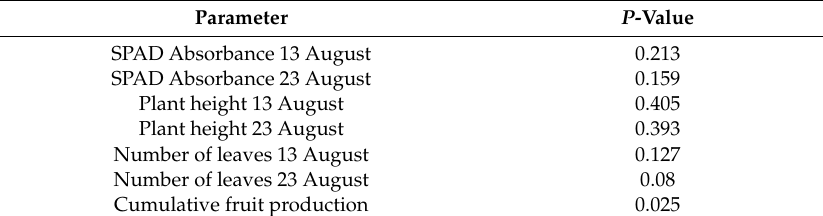
Table 6. P values for effect of two application rates of four composts on plant growth and health parameters.